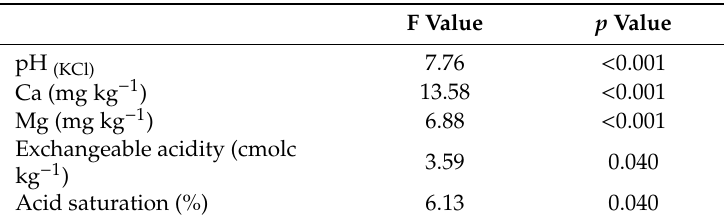
Table 7. F-and p values of pH (KCl) , Ca (mg kg − 1 ), Mg (mg kg − 1 ), exchangeable acidity (cmolc kg − 1 ), and acid saturation (%).